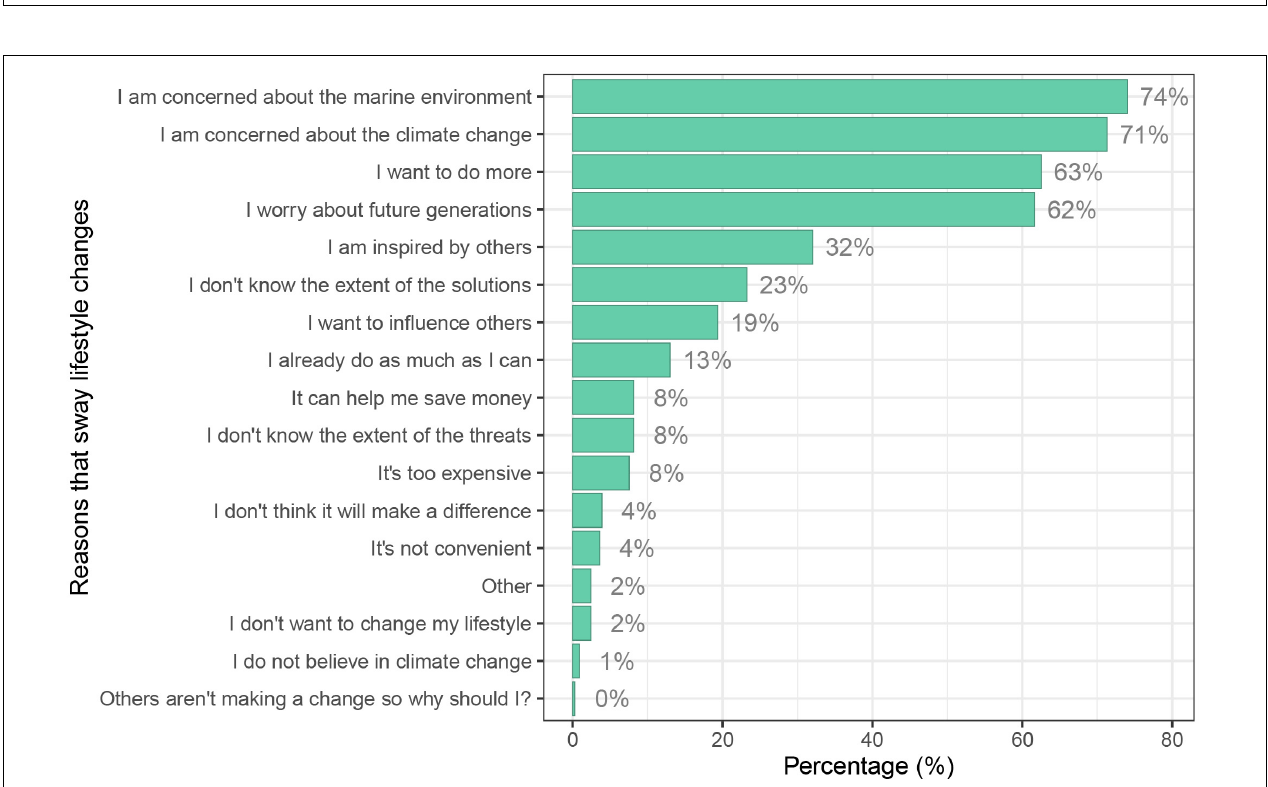
FIGURE 5 | Drivers for and barriers to lifestyle changes for ocean and climate ( n =